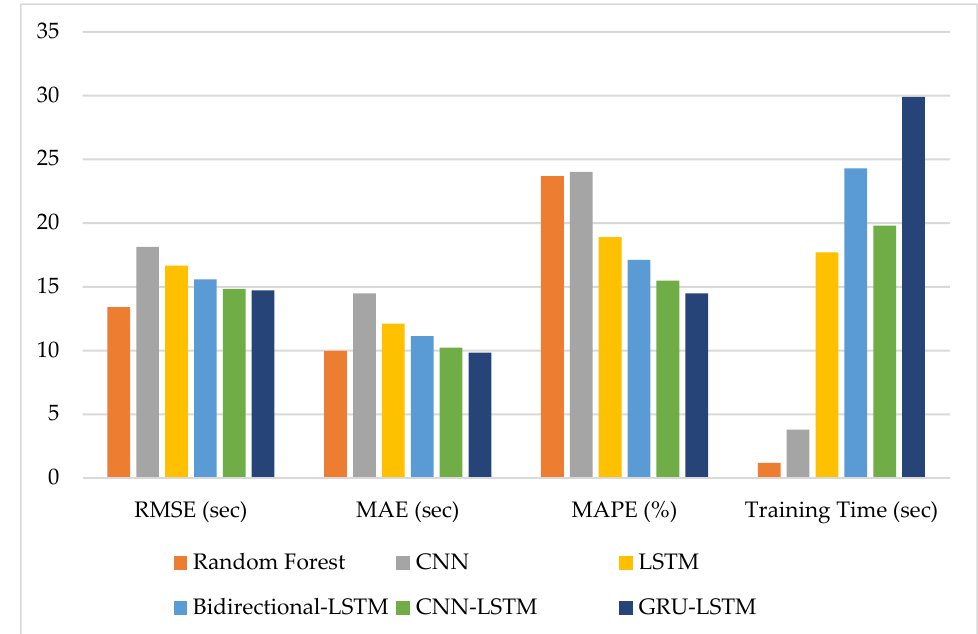
Figure 6. RMSE, MAE, MAPE, and training time for dwell time prediction.